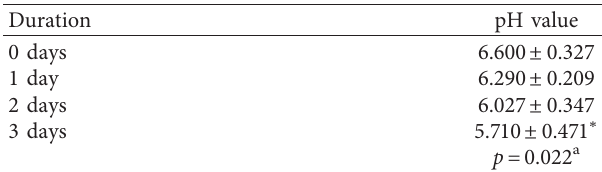
Table 5: Results of the acidity value (pH) of fermented shrimp sausages at different fermentation